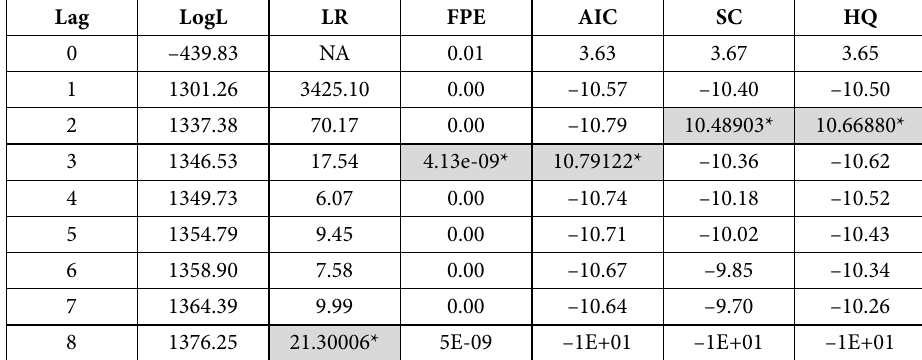
Table 3. VAR Lag order selection